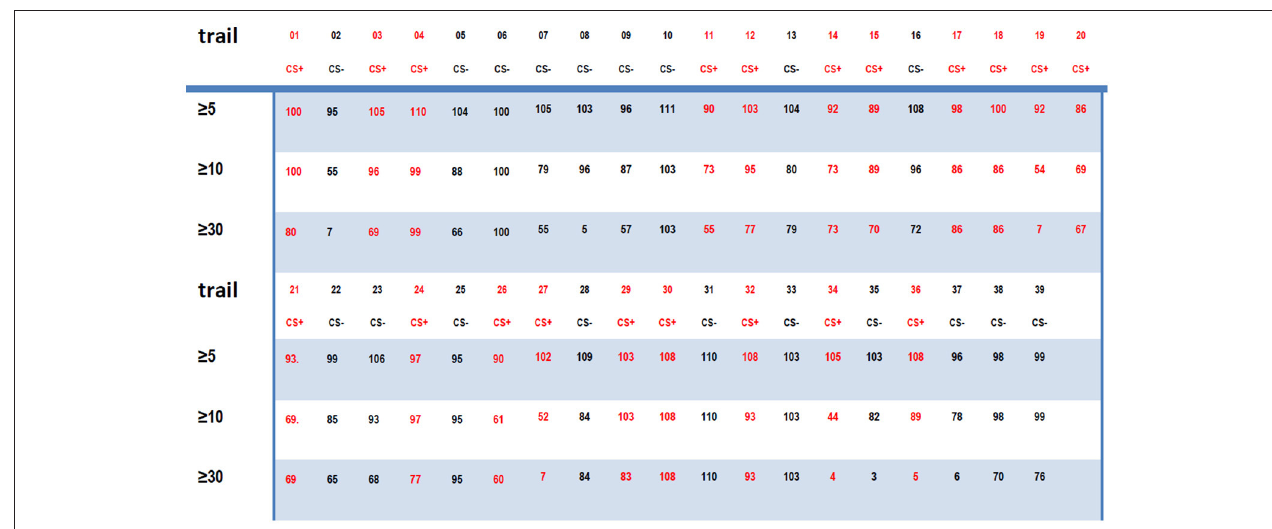
FIGURE 7 | The connectome indexes for the randomized ECoGs.